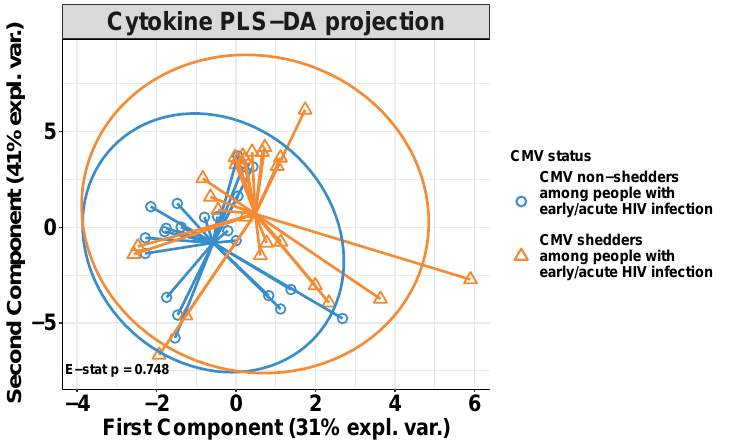
Figure 2. Two-dimensional PLS projections of blood cytokines in CMV shedders versus non-shedders. Shown are the PLS-DA projections in two LVs with ellipses representing Hotelling’s two-sample T2 with 95% confidence intervals in the blood plasma of people with early/acute HIV who shed CMV (orange triangles) and people who did not shed CMV (blue circles). PLS projections showed a large overlap between the cytokine profiles of CMV shedders versus non-shedders. The separation between the two groups, measured as the energy (E) statistic, was not statistically different (E-statistic p =